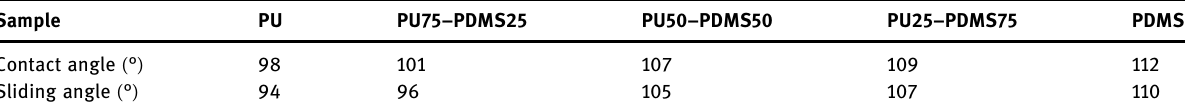
Table 2: The contact and sliding angles of PU – PDMS coated AISI 316L steel Sample